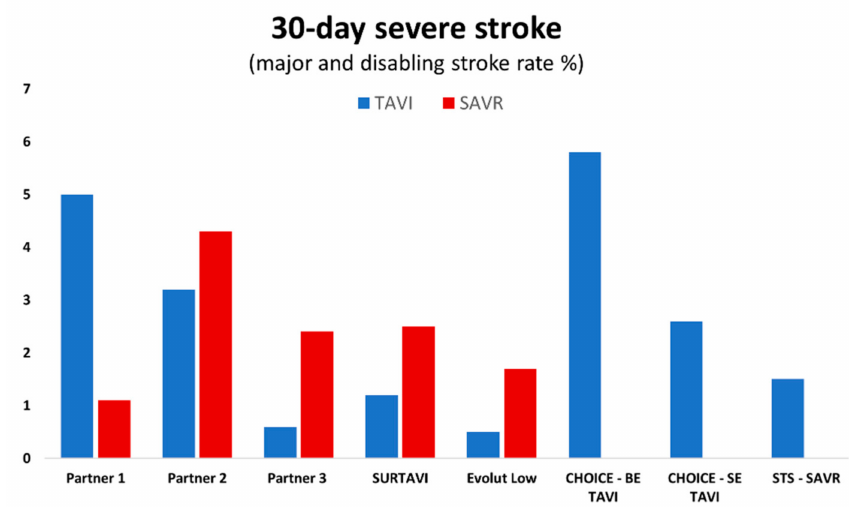
Figure 1. Rates of major and disabling stroke at 30-day follow-up in pivotal trials for TAVI (tran- scatheter aortic valve implantation) and SAVR (surgical aortic valve replacement).